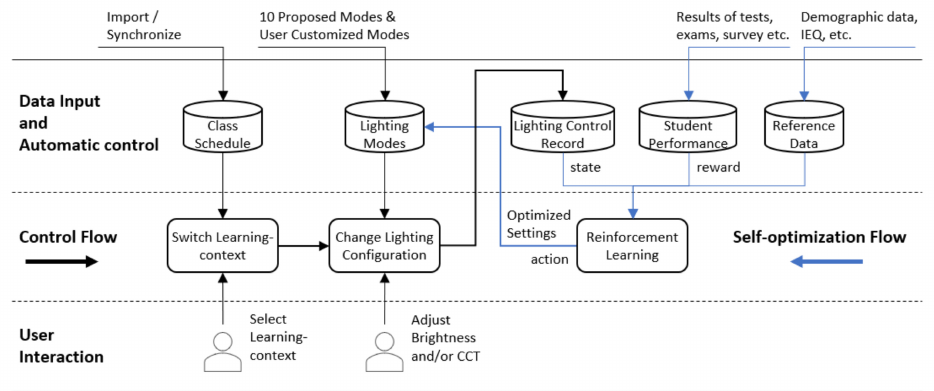
Figure 18. Classroom lighting environment self-optimization